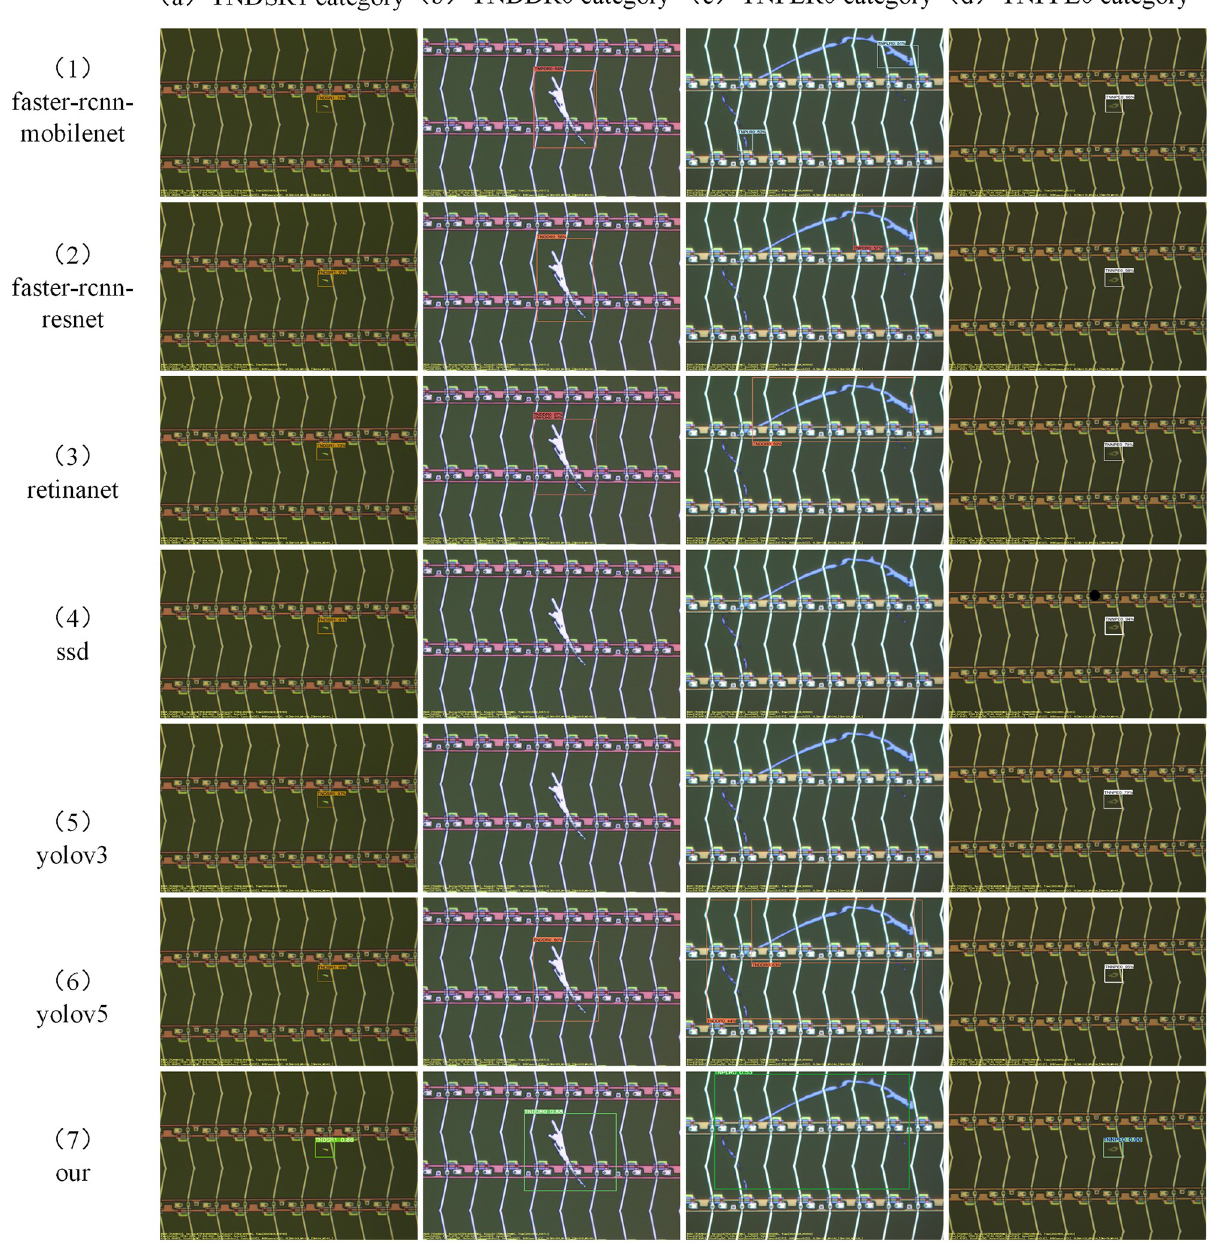
Fig 7. Four images in the TNSDR0 defect category are randomly selected from the test set and tested on our network and several state-of-the-art networks for comparison experiments. From top to bottom, they are Faster-rcnn (mobilenet), Faster-rcnn (resnet), retinanet, SSD, YOLOV3, YOLOV5, and our